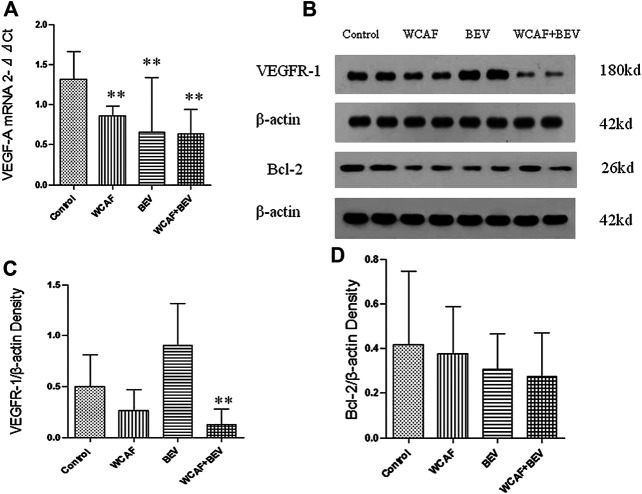
Effect of WCAF on the expression of VEGF-A, VEGFR-1, and BCL-2. (A) RT-PCR analysis of VEGF-A mRNA expression. **
p < 0.01 vs. control group. (B) Western blot analysis of the protein expression of VEGFR-1 and BCL-2. (C) Quantification of band intensities of VEGFR-1 expression.**
p < 0.01 vs. control group. △△
p < 0.01 vs. BEV group.(D) Quantification of band intensities of BCL-2 expression. **
p < 0.01 vs. control group.